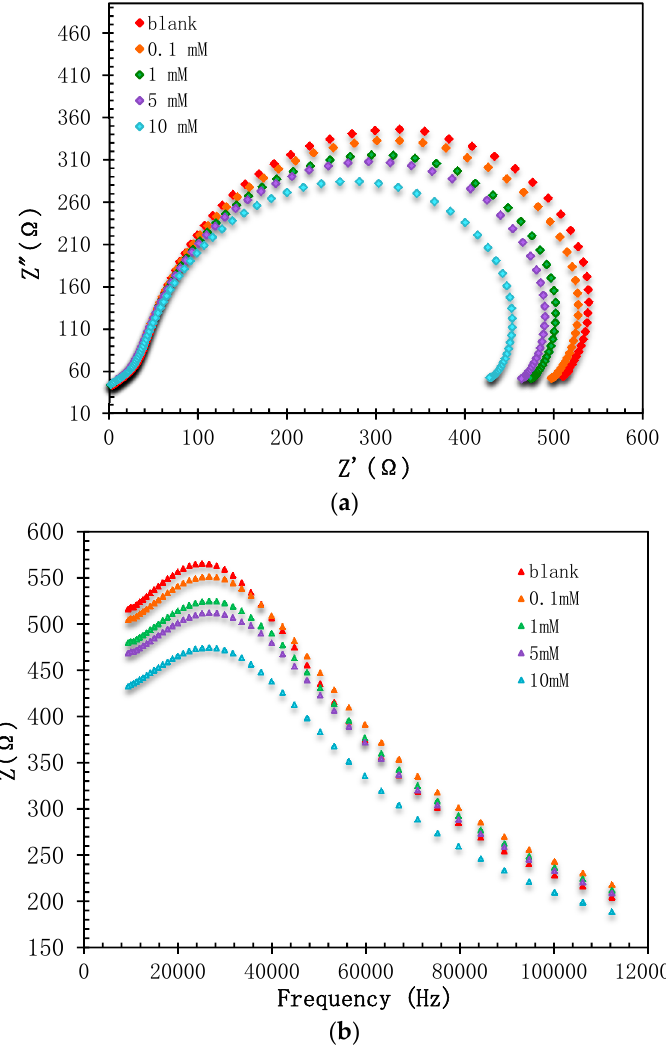
Figure 5. The ( a ) Nyquist and ( b ) Bode modulus plot for the Hb/TiAu-APTS/SPE biosensor at different H 2 O 2 concentrations.